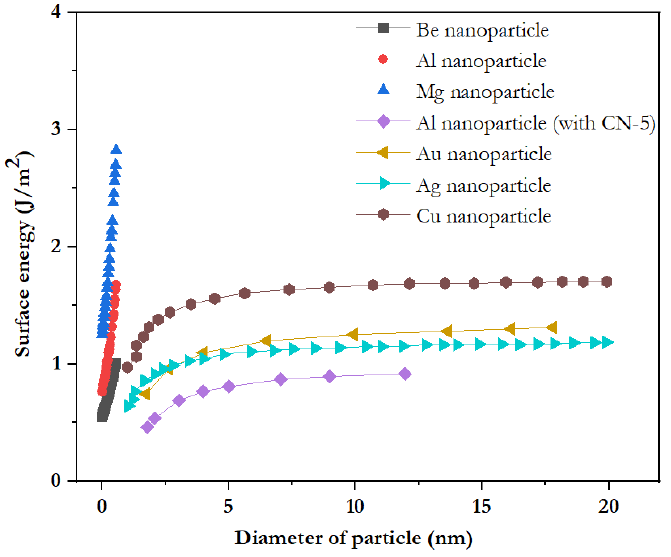
Figure 3. Variation of surface energy with particle diameter of Be, Al, Mg [29], Al (CN-5), Au [27], Ag and Cu [30].